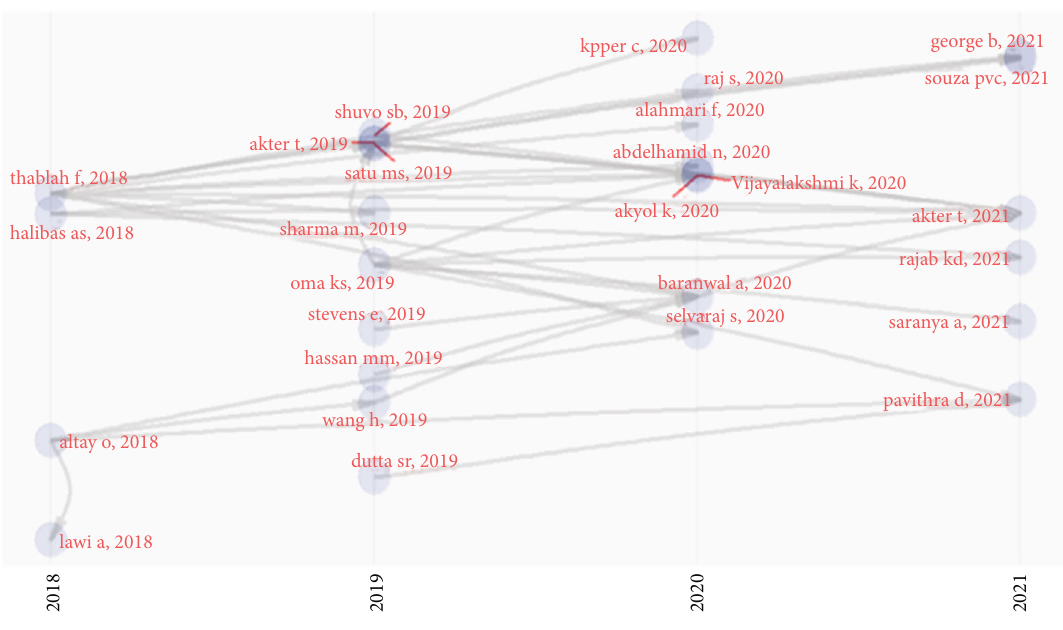
Figure 4: Historical direction citation